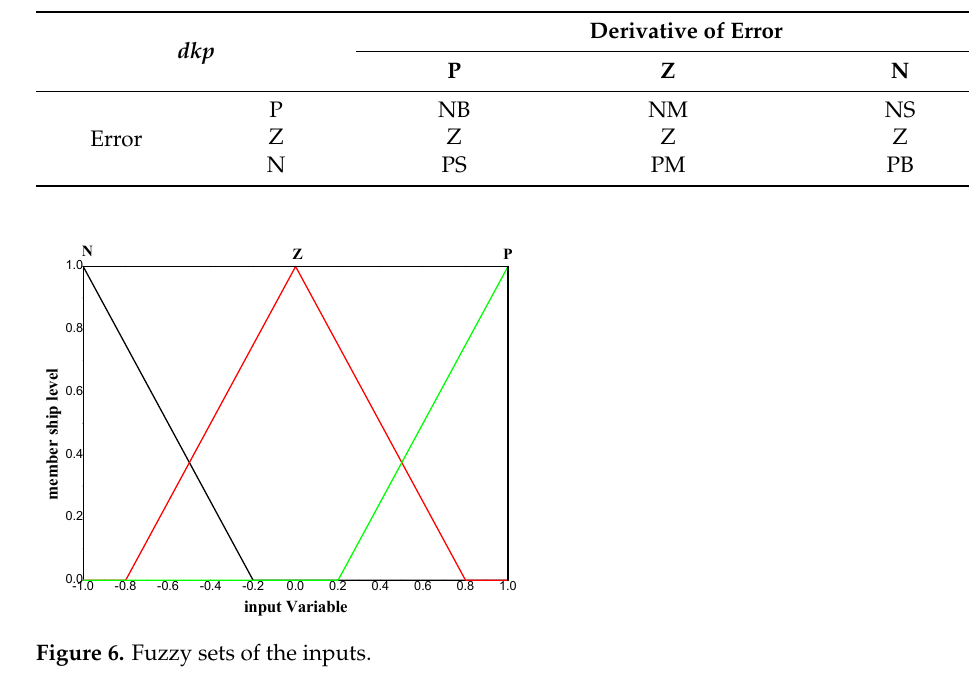
Table 1. Fuzzy PI Rule Table.